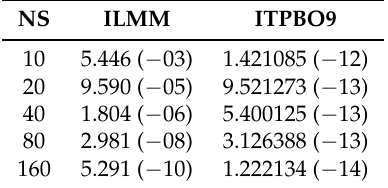
Table 4. Comparison of the maximum absolute errors on Problem 2, t ∈ [ 0,2 ] .